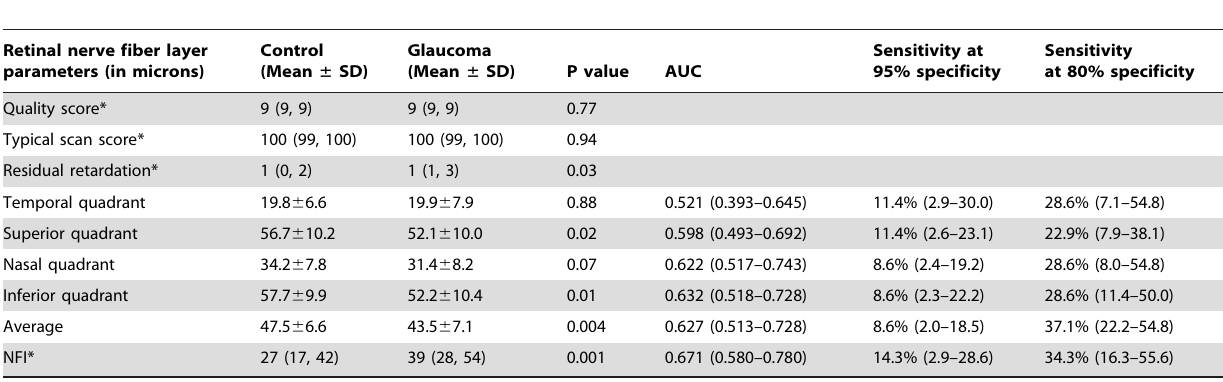
Table 3. Mean values of GDx ECC retinal nerve fiber layer parameters in glaucoma and control eyes with areas under the receiver operating characteristic curves and sensitivities at fixed specificities.